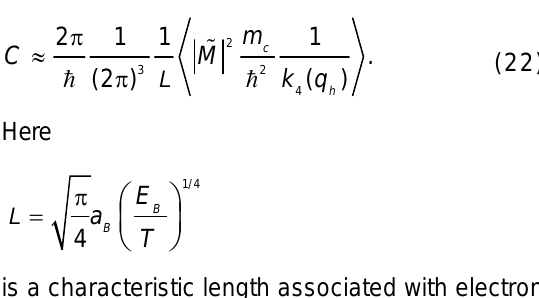
Fig. 3 . Dependences of C B , C width a .